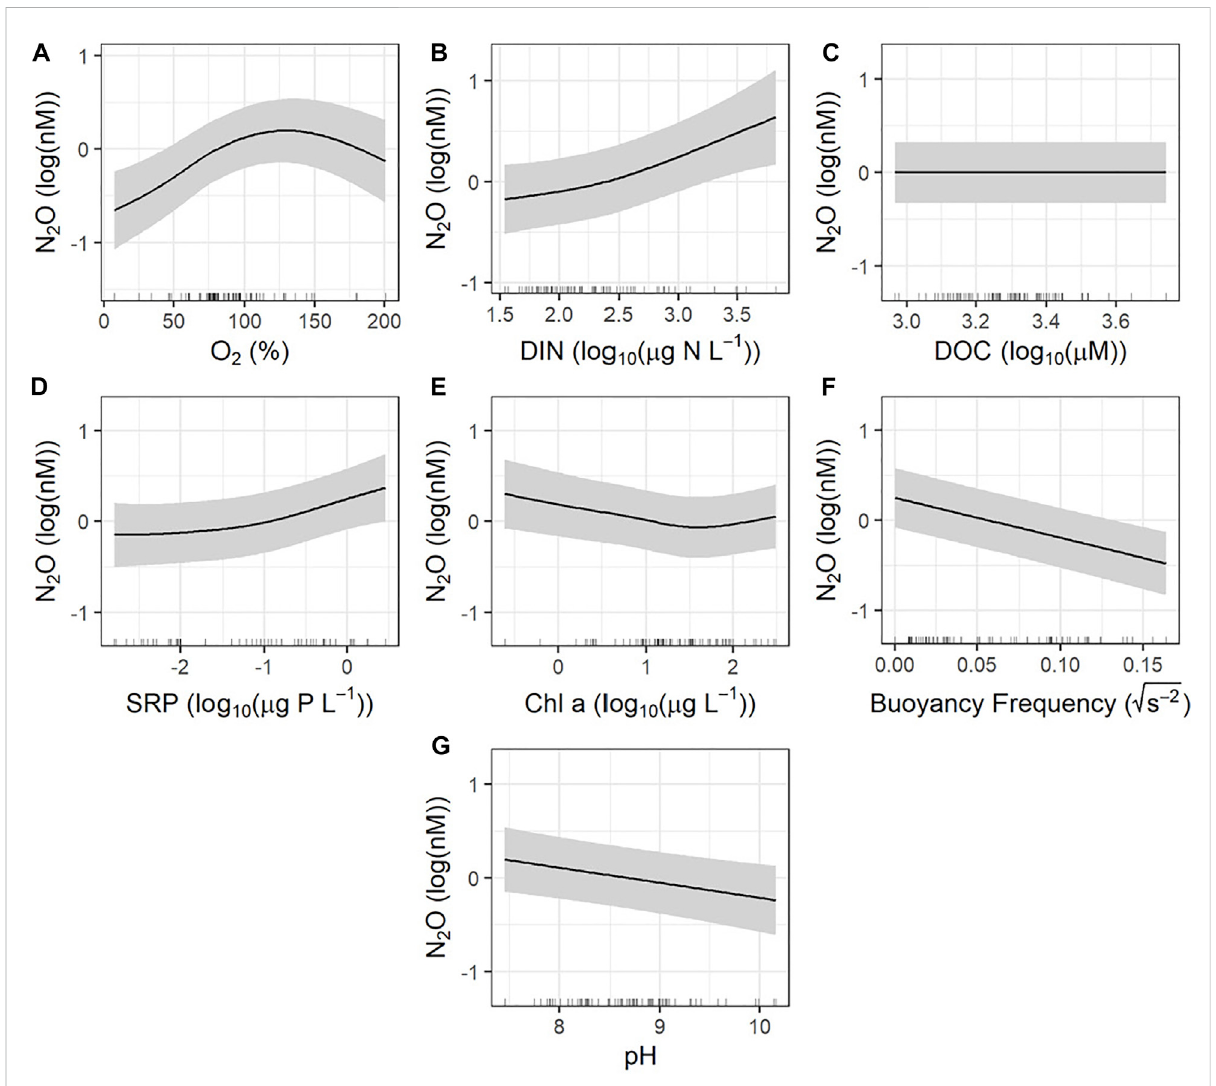
FIGURE 6 Partial effects plots from generalized additive models assessing the seasonal controls of nitrous oxide (N 2 O). Model deviance explained was 87.4%. Shaded region represents the 95% con fi dence interval. The rug along the x -axis indicates the distribution of observations. (A) Dissolved oxygen saturations; signi fi cant. (B) Dissolved inorganic nitrogen concentration; signi fi cant. (C) Dissolved organic carbon concentration; not signi fi cant. (D) Soluble reactive phosphorus concentration; signi fi cant. (E) Chl- a concentration; signi fi cant. (F) Buoyancy frequency (strati fi cation strength); signi fi cant. (G) pH; signi fi